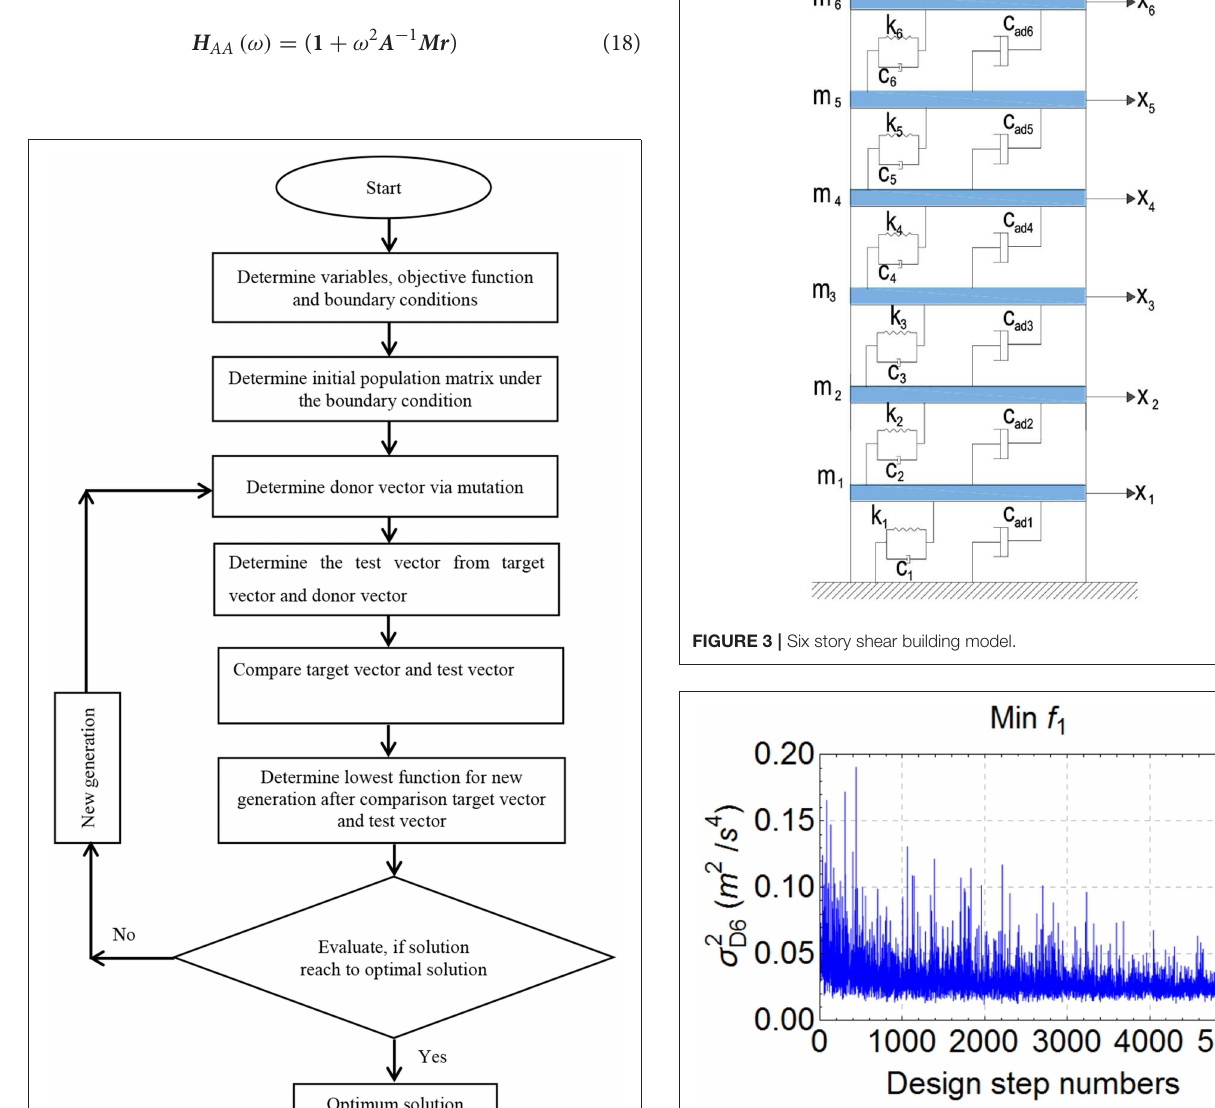
FIGURE 4 | Variation of objective function f 1 with respect to design step